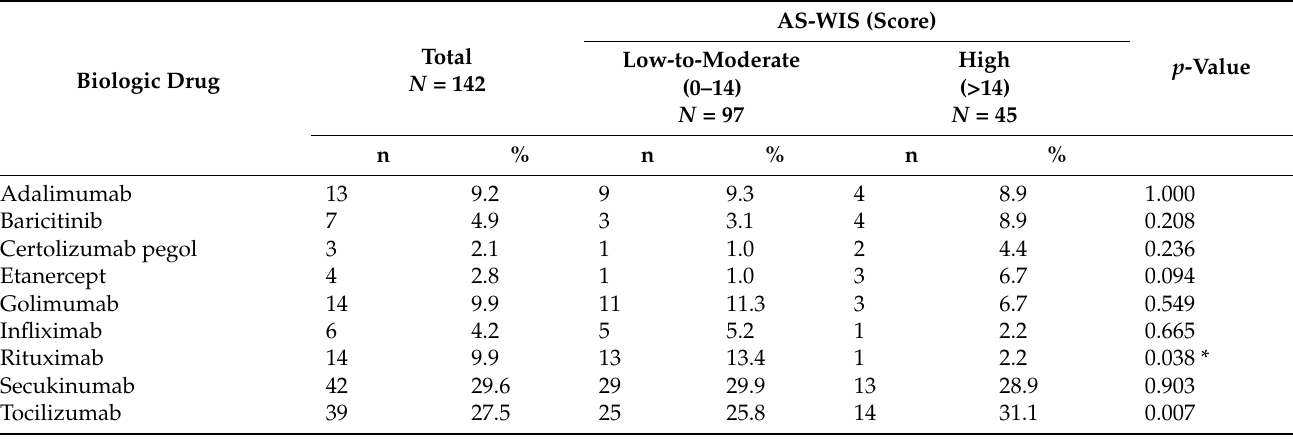
Table 6. The number (percentage) of RA patients in groups differing in terms of the level of risk of work disability and the biologics used, and the results of independence